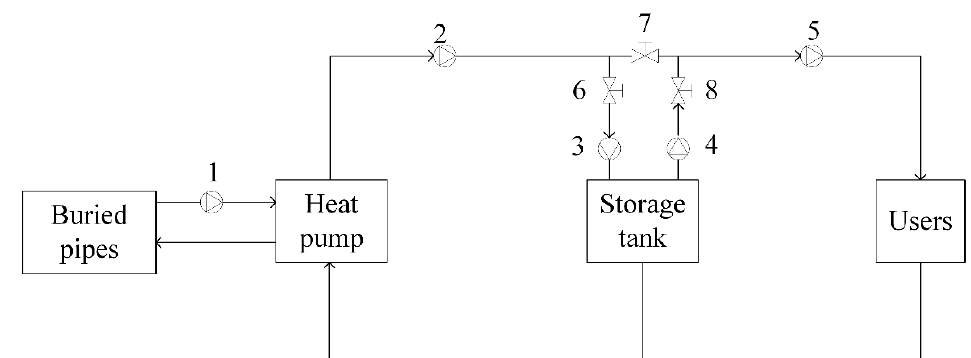
Figure 1. Schematic diagram of the medium-depth GSHP system (1—ground source side pump, 2—circulation pump, 3—heat storage pump, 4—heat release pump, 5—heat storage valve, 6—heating valve, 7 and 8—operating mode control valve .